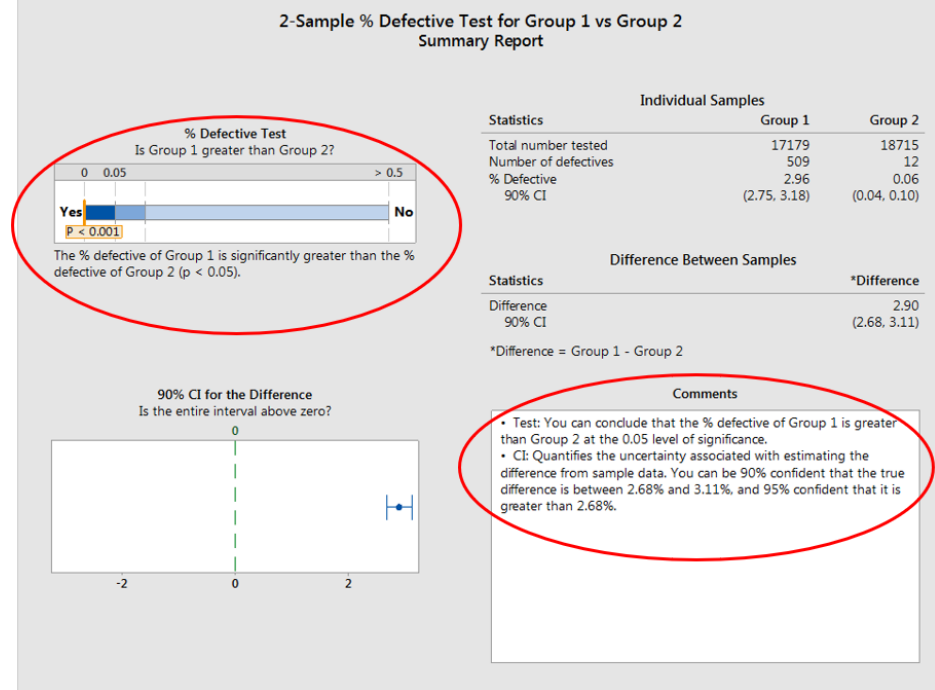
Figure 23. The di ff erence between the two series of actions. Figure 23. The difference between the two series of actions.